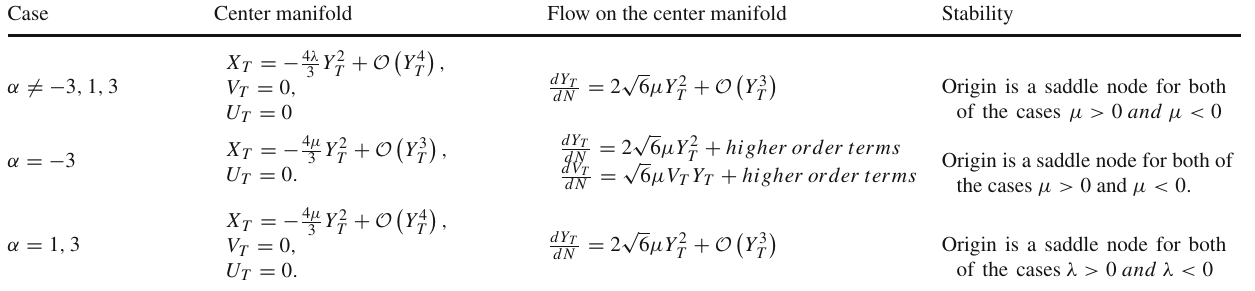
Table 9 Center manifold, flow on the CM and the stability near the origin corresponding to the critical point B 2 Case